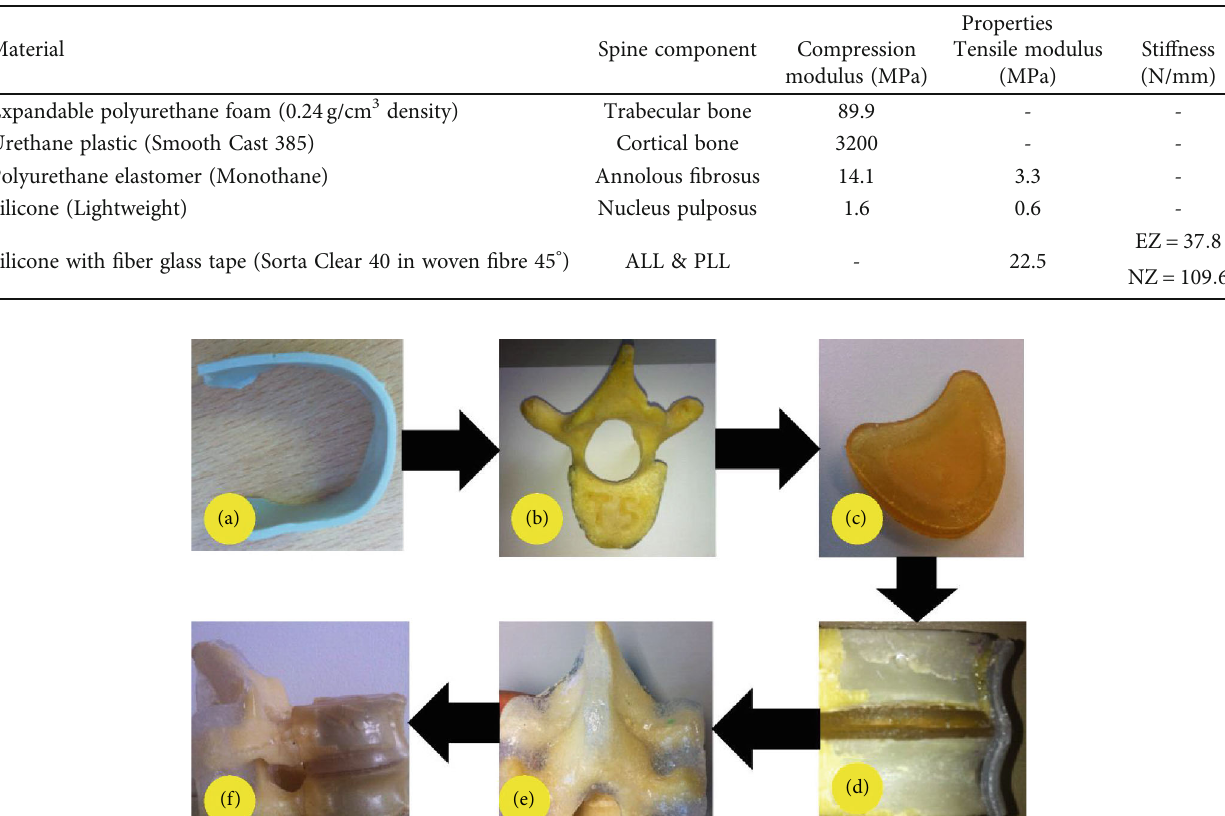
Table 1: Material properties of the components in the fabricated synthetic paediatric spine.